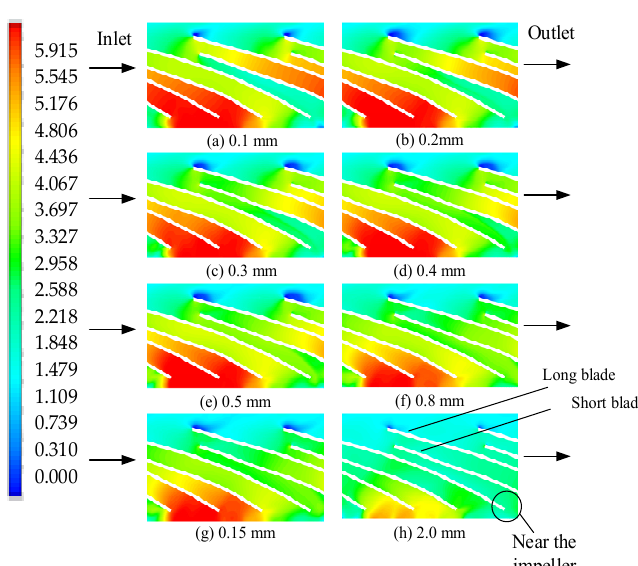
Figure 9. Pressure distribution in the passage between blades.